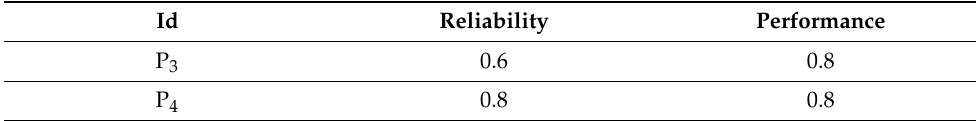
Table 11. PSS variants’ contributions to domain utility dimensions.